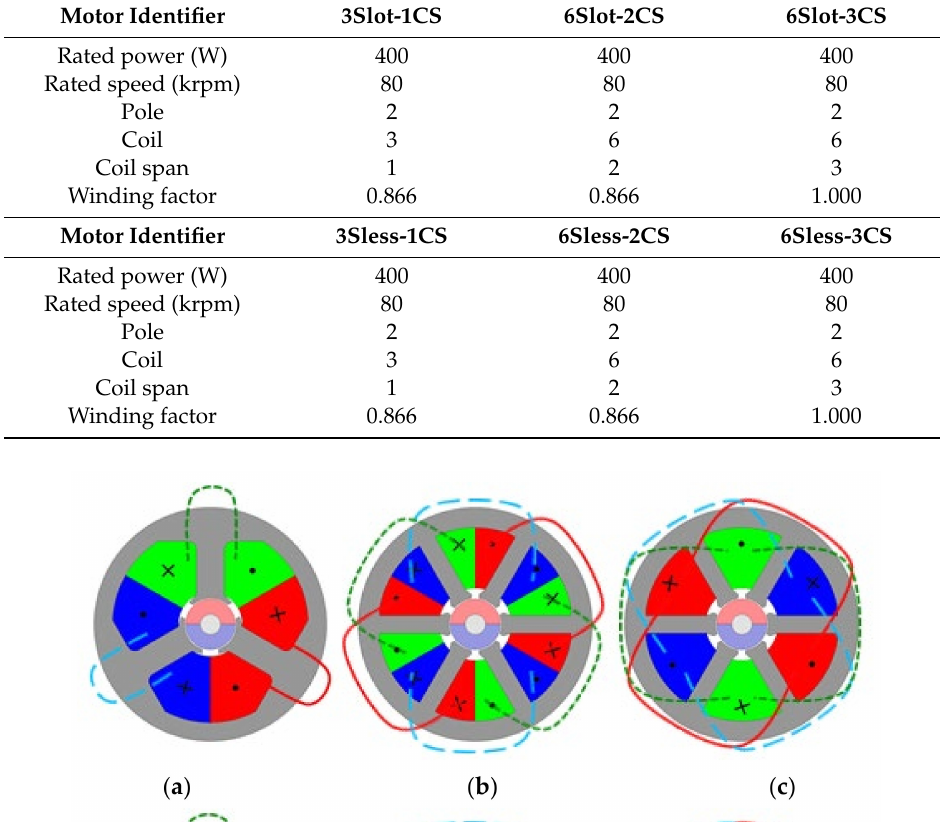
Table 2. The main characteristics of six di ff erent motor topologies.